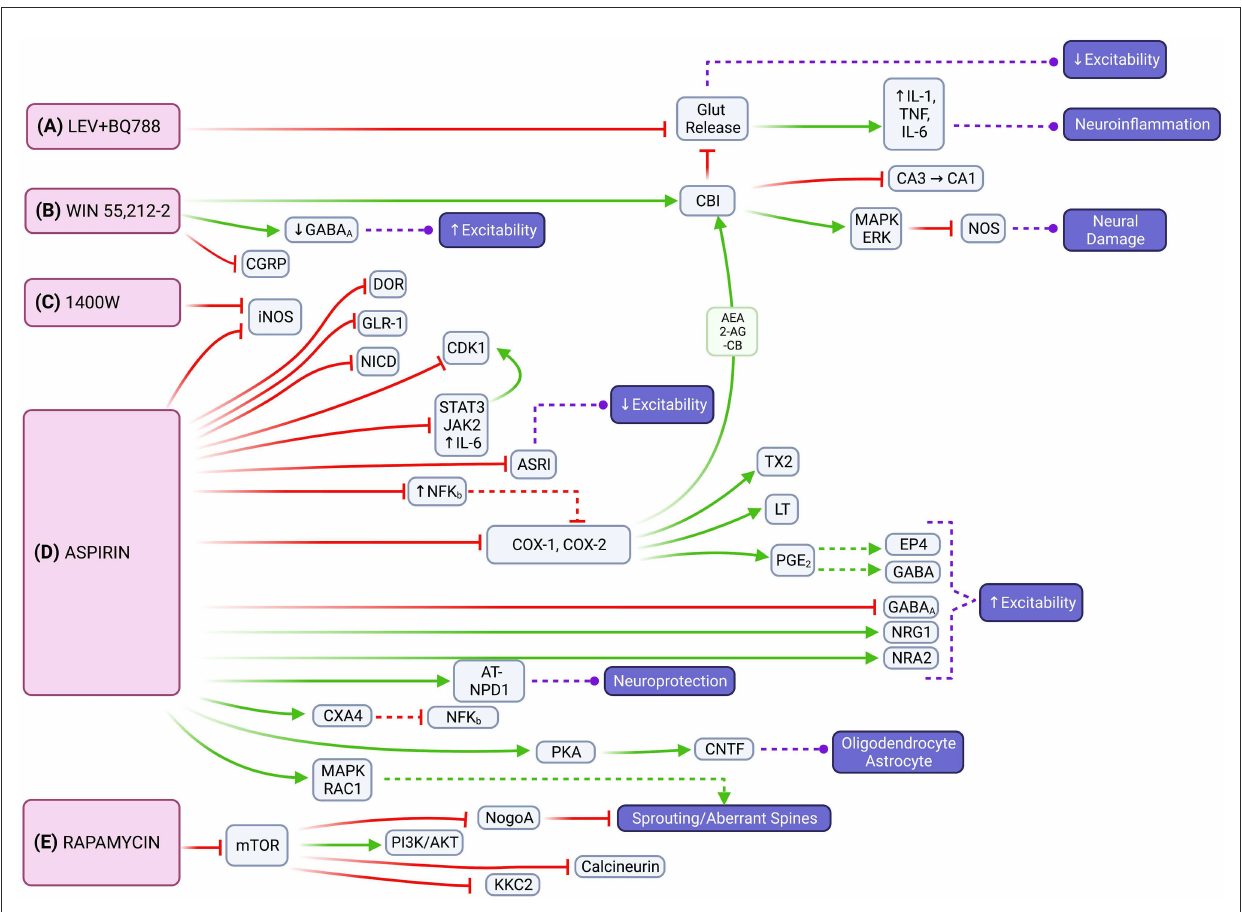
FIGURE4 Molecular signaling mediated by LEV + BQ788, WIN 55,212-2, 1400W, aspirin and rapamycin that represents possible targets to mitigate epileptogenesis through multiple pathways. (A) The combination of LEV with BQ788 has the potential to attenuate neuroexcitability and neuroinflammation by inhibiting glutamate transmission. (B) WIN 55,212-2 acts on the CB1 receptor that leads to the activation of the mitogen-activated protein kinase (MAPK) and retrograde inhibition of neurotransmitter release [e.g., inhibition of nitric oxide synthase (NOS)]. (C) 1400W is an inhibitor of iNOS. (D) Aspirin also inhibits iNOS, as well as reduces expression of DOR, IL6/JAK2/STAT3, and NFK B . Neuroinflammation can be limited through aspirin’s inhibition of COX1/COX2 and the endocannabinoid system [e.g., 2-arachidonoylglycerol (2-AG), arachidonoylethanolamine (AEA)]. Neuroprotective effects are instigated through activation of NR2A or PKA with subsequent CNTF release. (E) Through its effects on mTOR signaling, rapamycin has the potential to regulate axonal fiber regeneration via NogoA. It also reduces expression